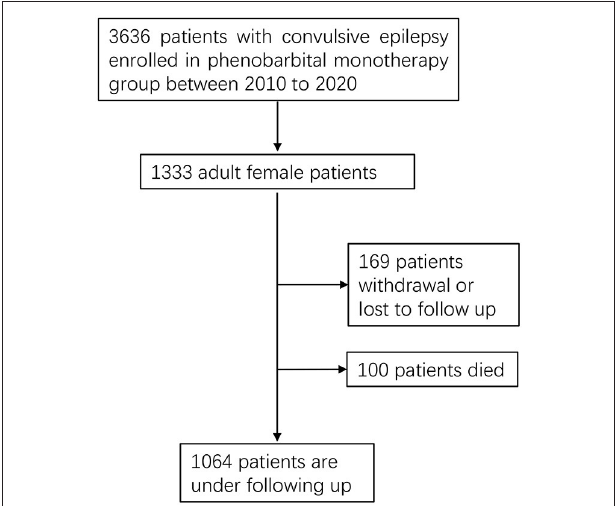
FIGURE 1 | Flow diagram of participant